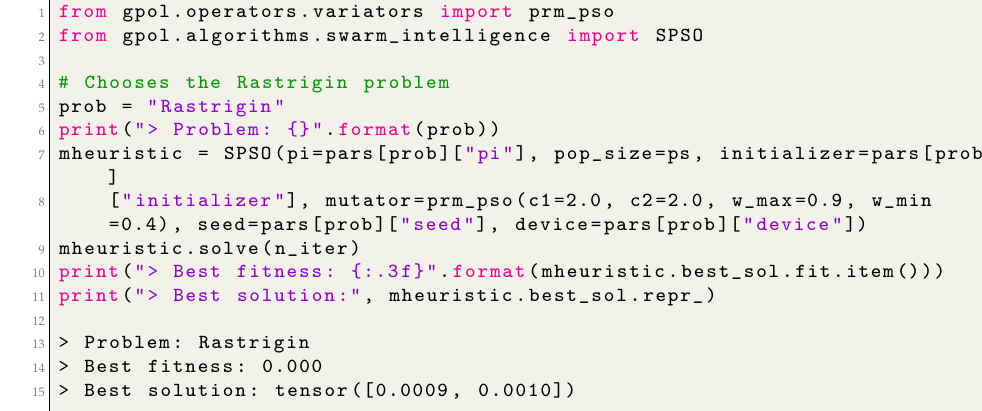
Figure A11. An example of SPSO ’s application in continuous